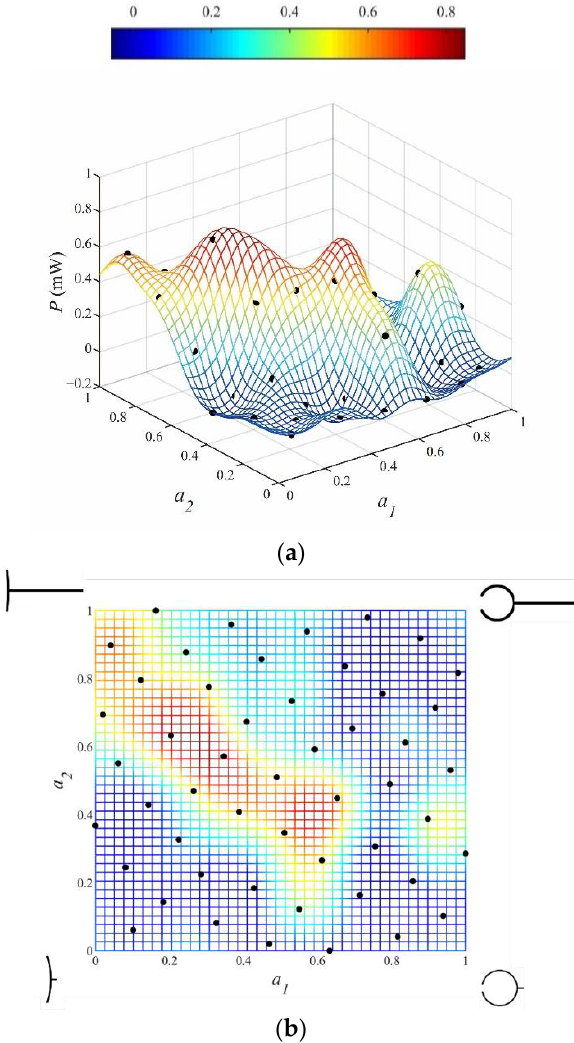
Figure 6. Kriging model for the average output power in ( a ) three-dimensional and ( b ) two-dimensional cartesian.